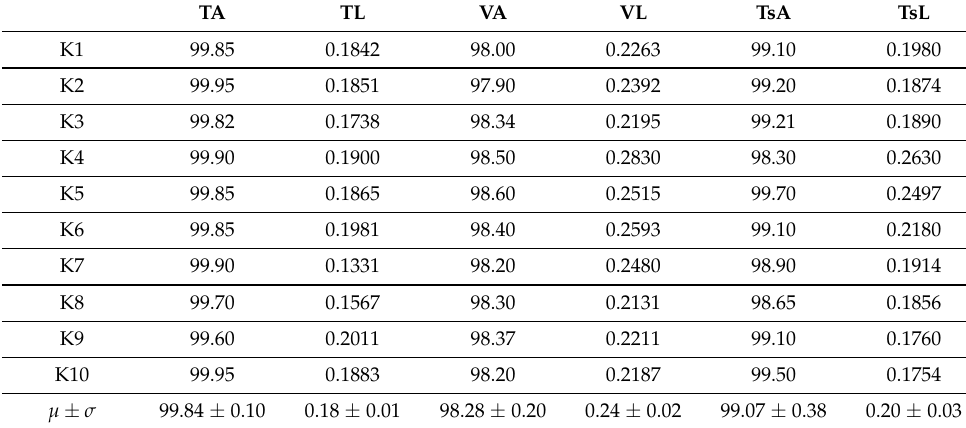
Table 3. Ten-fold training, testing, and validation performance in percentages; training accuracy (TA), validation accuracy (VA), training loss (TL), validation loss (VL), test accuracy (TsA), and test loss (TsL).